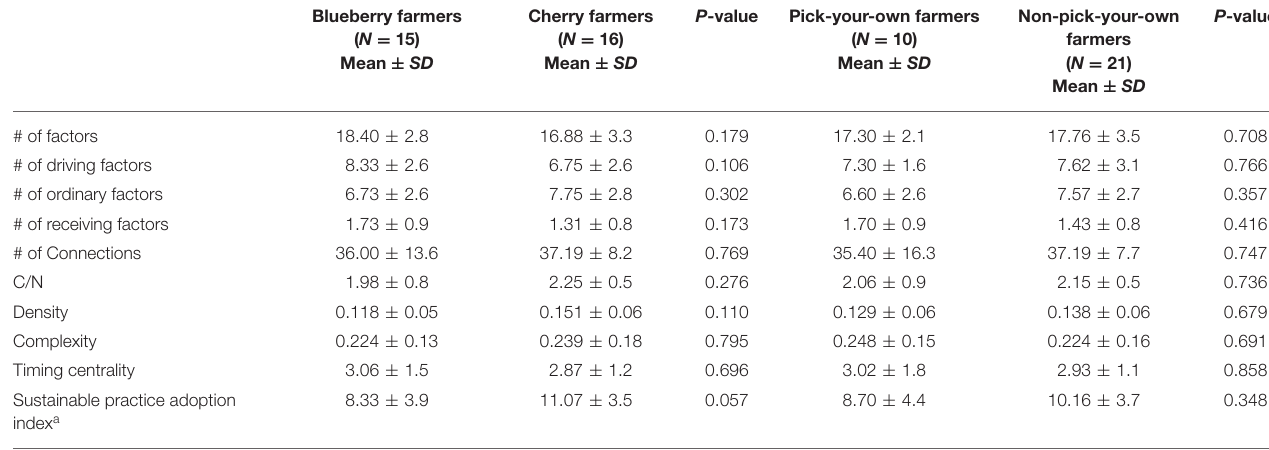
TABLE 1 | Mean differences in mental model metrics and adoption of sustainable practices index by farm